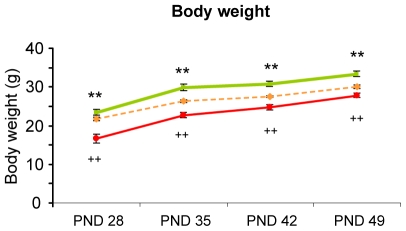
Body weight after weaning of animals fed with bacteria, blue-green algae and standard diet.Compared to standard fed HAB animals (orange dotted line), blue-green algae diet fed animals were significantly heavier (green line) and bacteria fed animals lighter (red line) (**p<0.01 blue-green algae vs. control ++p<0.01 bacteria vs. control).